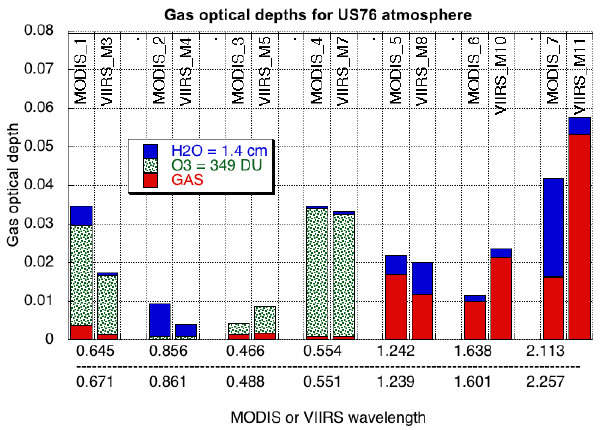
Figure 5. Comparison of gas optical depths calculated for the US 1976 Standard Atmosphere using MODIS C6 and VIIRS gas cor- rection coefficients. Different colors represent constituent gases (H 2 O is blue O 3 is green hatched and “dry” gas is red). Large dif- ferences in gas optical depths are seen in MODIS channels 1, 2, 6 and